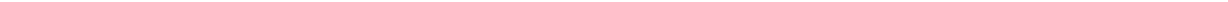
Fig. 3 mstnb LOF and inhbaa GOF positively affect physiological CM proliferation and cardiac regeneration. a Experimental setup of EdU treatment, followed by heart extraction and fi xation. b , c Sections of mstnb + / + and mstnb − / − adult hearts in Tg(myl7:nlsDsRedExpress) background; α -DsRed (red), MF-20 (blue), EdU (green). Higher magni fi cations of dashed boxes in b , c are shown in upper right corners. White arrowheads point to EdU + /DsRed + CMs. d , e Quanti fi cation of total CMs (DsRed + ) and EdU incorporating CMs (EdU + /DsRed + ) in the compact and trabecular layers of mstnb + / + ( n = 5) and mstnb − / − ( n = 5) ventricles. f , g Sections of wild-type sibling and inhbaa OE adult hearts in Tg(myl7:nlsDsRedExpress) background; α -DsRed (red), EdU (green). Higher magni fi cations of dashed boxes in f , g are shown in upper left and upper right corners. h , i Quanti fi cation of total CMs (DsRed + ) and EdU incorporating CMs (EdU + /DsRed + ) in wild-type sibling ( n = 5) and inhbaa OE ( n = 5) hearts. All cell counts were performed on three sections from each heart. Each data point on dot plot represents one heart (data are mean ± s.e.m., * P ≤ 0.05, ** P ≤ 0.01, *** P ≤ 0.001 — Student ’ s t test, two-tailed). j – m AFOG staining of sections from mstnb + / + ( n = 3), mstnb − / − ( n = 4), wild-type sibling ( n = 4), and inhbaa OE ( n = 4) cryoinjured hearts at 30 dpci. Asterisks indicate the regions of resolved scarring. The numerators indicate the number of hearts with a particular pattern of scarring, and the denominators the total number of hearts analyzed. Scale bars, 100 µ m. dpt, days post treatment; vent., ventricle; atr.,